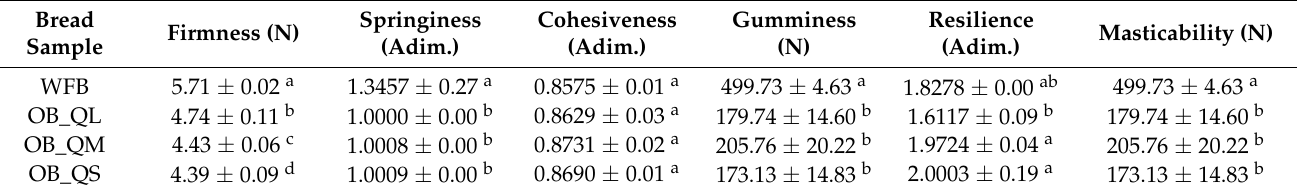
Table 5. Texture parameters of bread with the optimal dose corresponding to the large, medium and small particle size of quinoa flour vs. wheat flour bread.